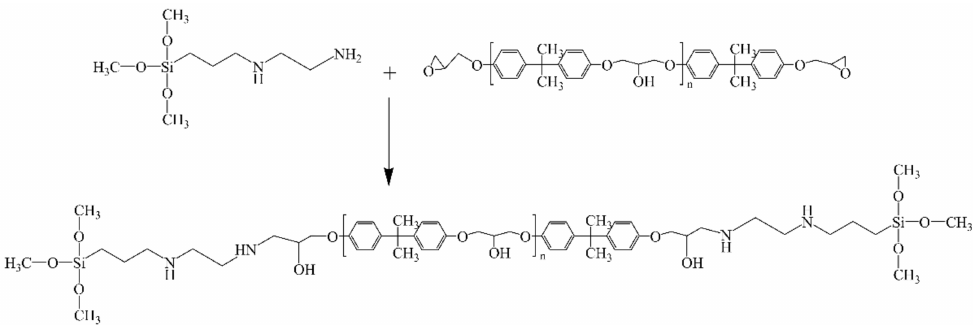
Figure 1. The reaction principle of DAMO and E51. Samples were prepared according to the experimental design scheme. The formulation of the epoxy-modified silicone tie-paint is presented in Table 1, in which TEOS and DBTDL were used respectively as crosslinking curing agents and a catalyst was used to ensure that the system could be cured at room temperature. These coatings were prepared by an air spraying method to ensure that the same coatings in the samples were made with the same spraying pressure, speed, and spraying times. All the samples were flat and were placed in a high-low temperature damp heat test box at 25 ◦ C and a humidity of 60% for curing for 7 days and were then removed for testing. The samples labeled ES-X, X represent the content (token integer) of E51 (mass%) in the formulation of the epoxy-modified silicone